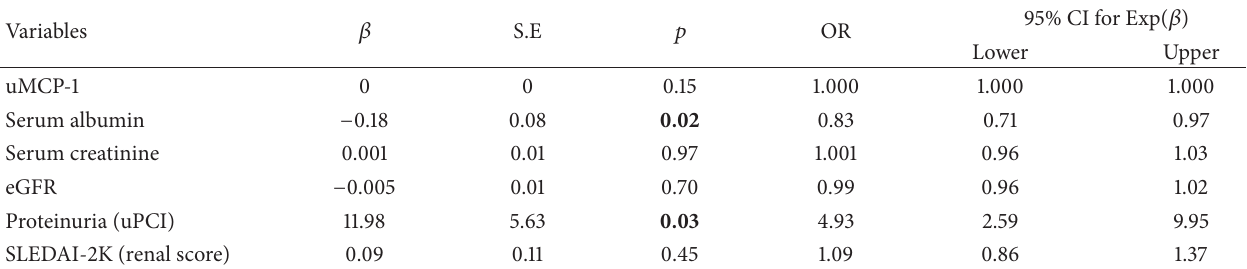
Table 7: Predictors of LN outcome at 4 months’ follow-up.